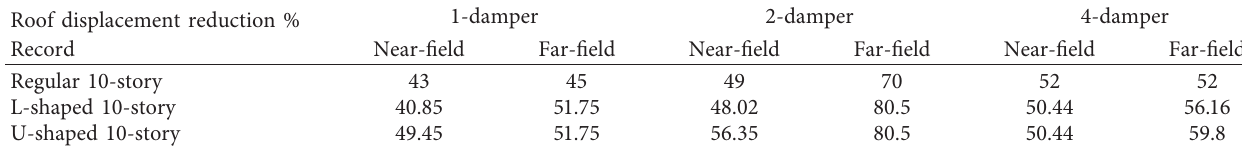
Table 8: Maximum displacement reduction percentage of roof in the regular and irregular 10-story models.